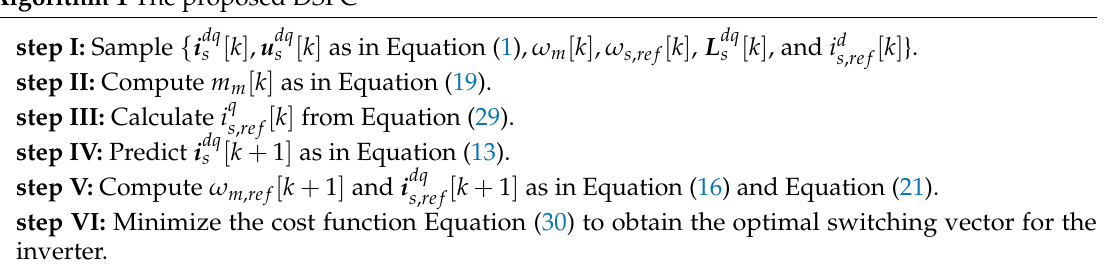
Algorithm 1 The proposed